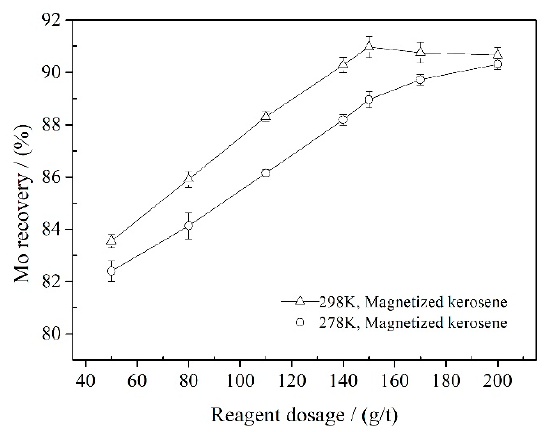
Figure 4. The influence of low-temperature pulp on the flotation performance of MK.